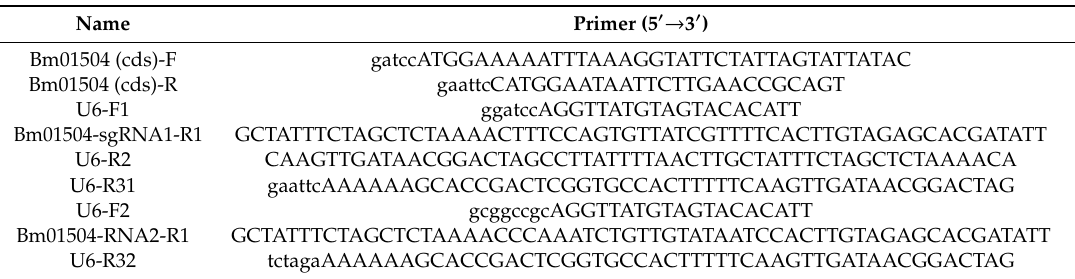
Table 3. Primer sequences for vector